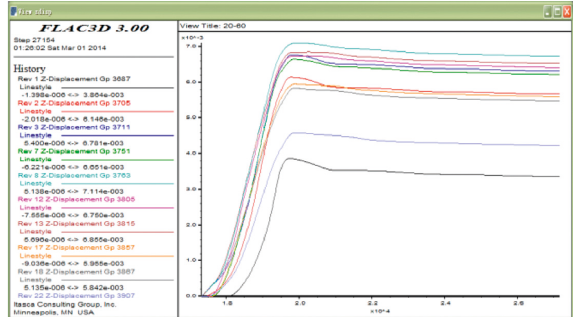
Figure 6: The vertical deformation for each history point of 20–60 type. (a) Thickness of the asphalt layer with 10 cm. (b) Thickness of the asphalt layer with 15cm. (c) Thickness of the asphalt layer with 18cm. (d) Thickness of the asphalt layer with 20cm.